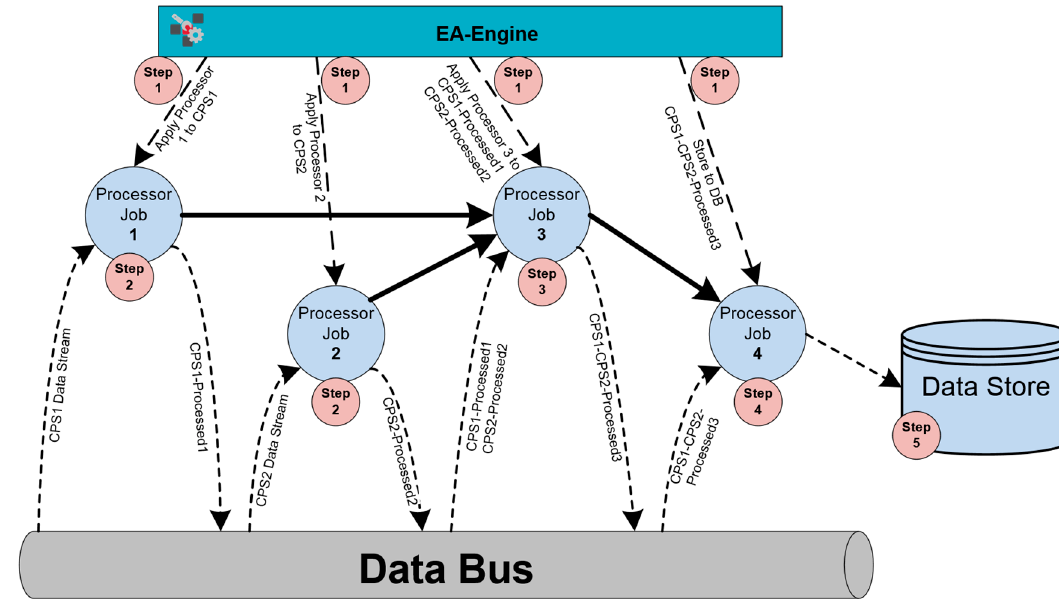
Figure 2. Configurable Data Preprocessing at the Edge.